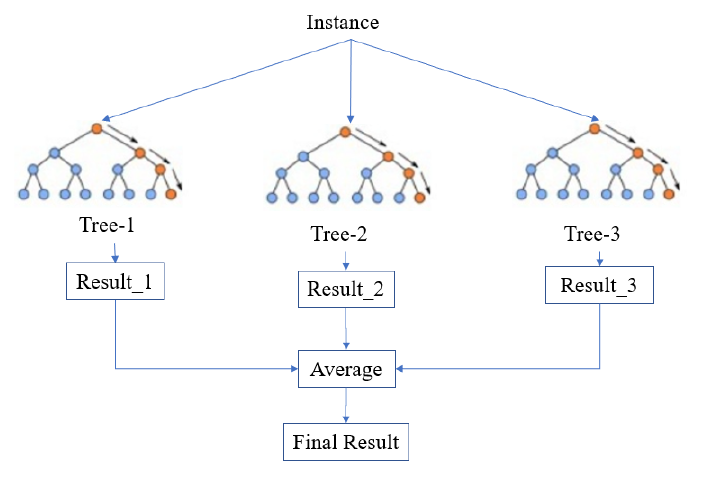
Figure 1. Simplified structure of random forest.